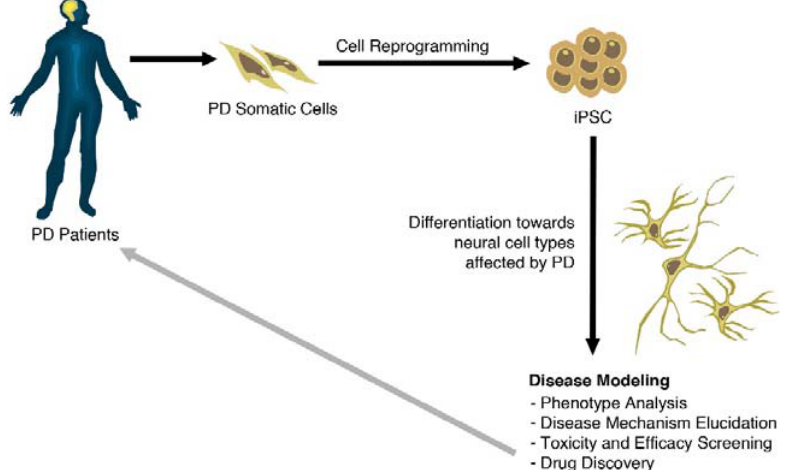
Figure 1. Generation and use of iPSC modelling in PD. Somatic cells from a diseased patient are isolated and then reprogrammed to a pluripotent state (iPSCs). iPSCs can be maintained in culture or induced to differentiate along tissue- and cell-type specific pathways. Differentiated cells can be used to elucidate disease mechanism pathways, as well as for the development of novel